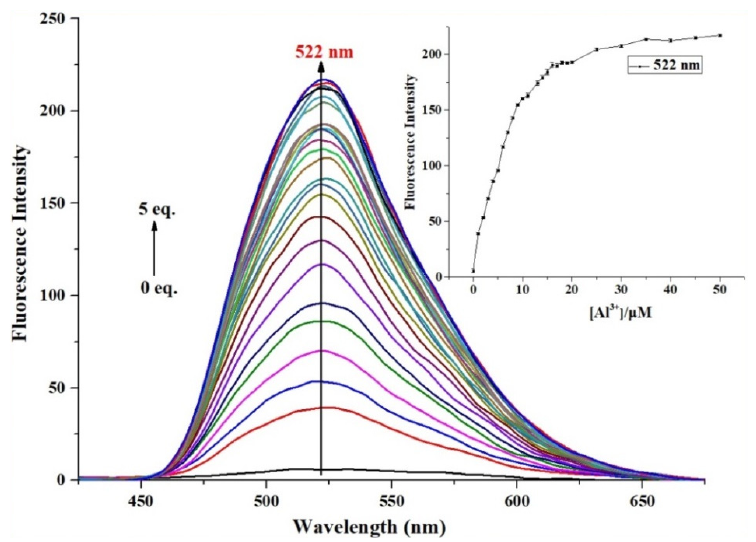
Figure 2. Fluorescence titration spectrum of BHMMP (10 µM), with varying ratios of Al 3+ (0–5 eq.) in EtOH/H 2 O (2/3, v / v , 0.01 M HEPES, pH = 5) medium, λ ex = 370 nm. Inset: The variation trend of fluorescence intensity of BHMMP at 522 nm with increasing Al 3+ concentration.